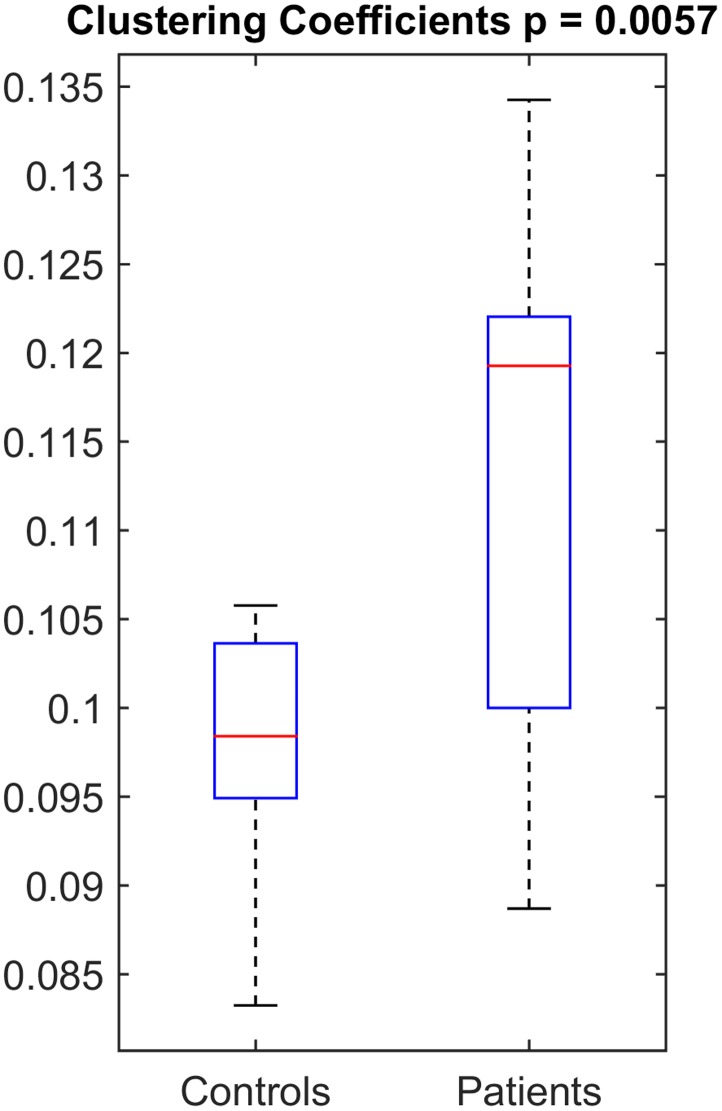
The distribution of clustering coefficient of PDC in beta band as a box-plot in patients vs. controls, showing the median and interquartile range.